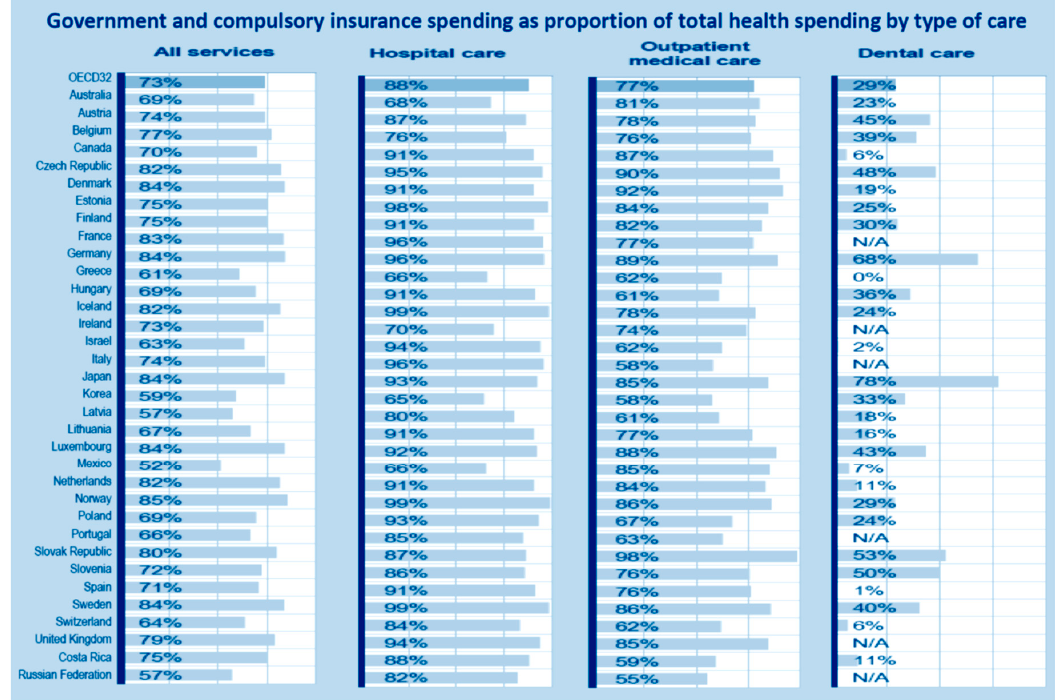
Figure 28. The extent of coverage of financing medical services in 2017 by government and compulsory insurance including that dedicated to dental care. Processes 2020 , 9 , x FOR PEER REVIEW